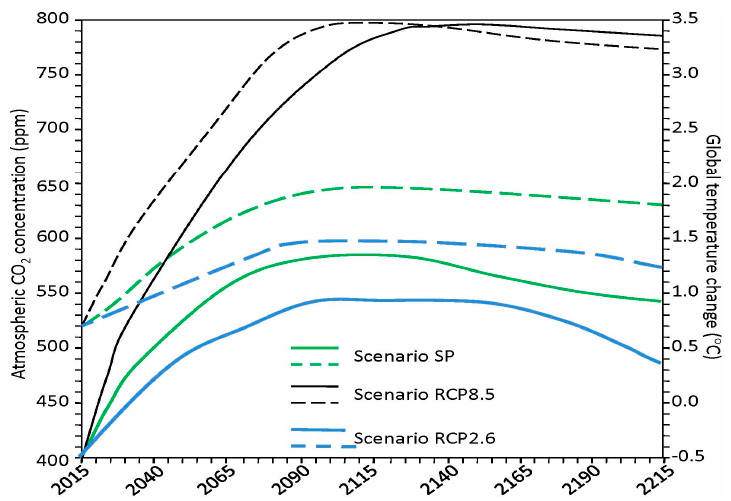
Figure 11. The dynamics of the climatic factors (CO 2 concentration and temperature are represented by the solid and dashed lines, respectively). A comparison of the results obtained from the implementation of the SP scenario with those from the RCP8.5 and RCP2.6 scenarios